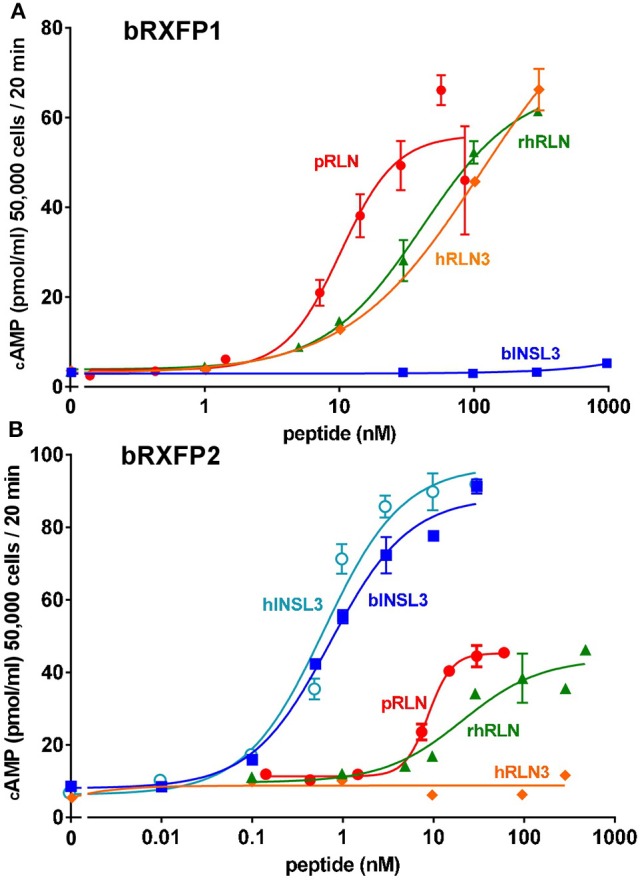
Dose-response curves for cAMP production by HEK293T cells transiently transfected with either bRXFP1 (A) or bRXFP2 (B) and stimulated by increasing concentrations of porcine relaxin (pRLN), recombinant human relaxin (rhRLN), relaxin 3 (RLN3), bovine INSL3 (bINSL3), or human INSL3 (hINSL3), as indicated.